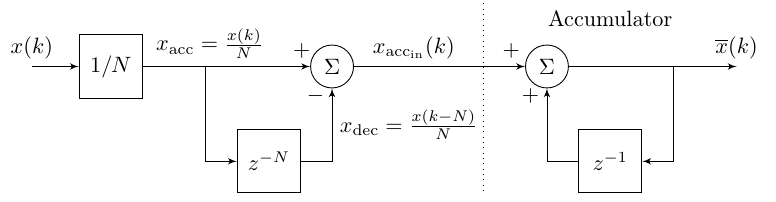
Figure 1. A MA block built from Equation (14), adapted from